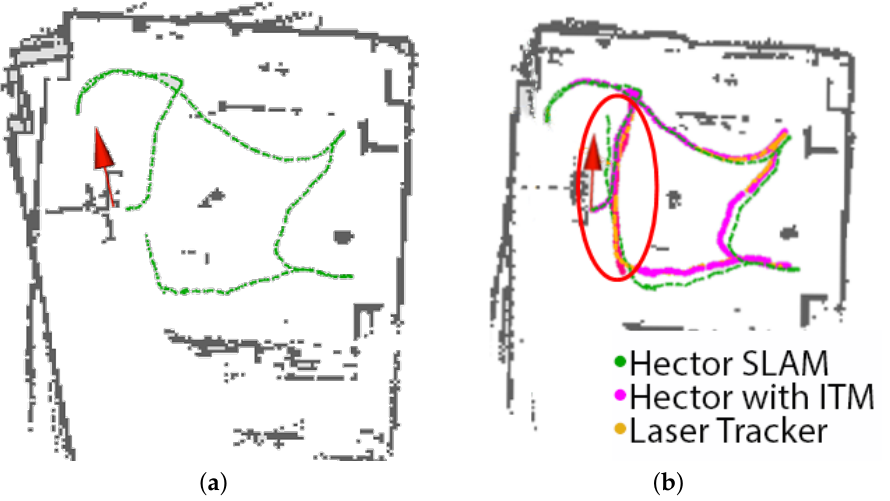
Figure 6. Mapping and trajectory in RMRL lab. ( a ) Native Hector SLAM Process; ( b ) A ITM interpolated Hector SLAM